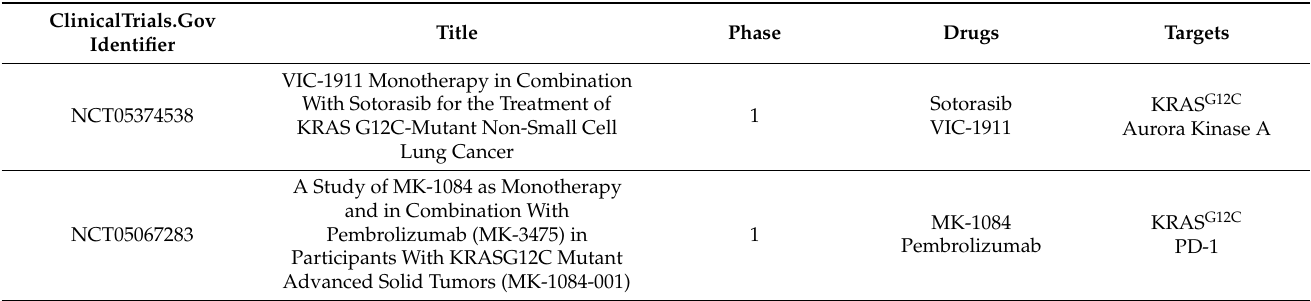
Table 1. Registered trials of KRAS G12C inhibitor combination therapy on